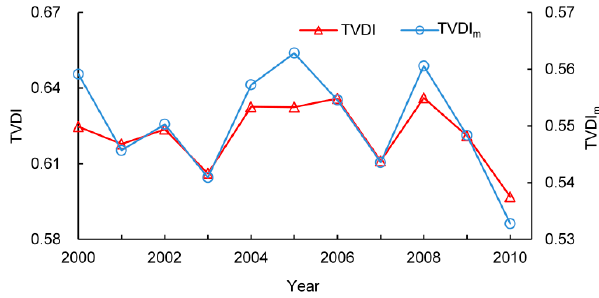
Figure 11. TVDI (red line) and TVDI m (blue line) curves from 2000 to 2010 in Ningxia Province, China.